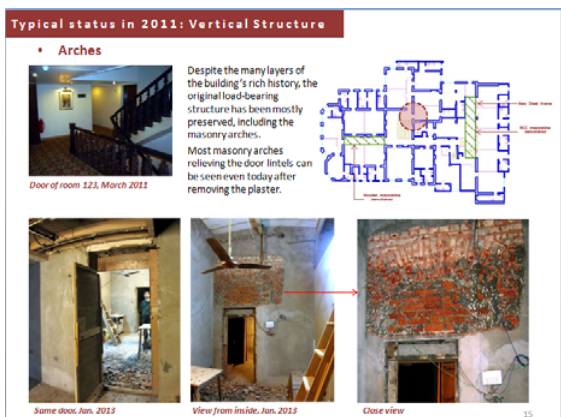
Figure 5: Site survey plan of the